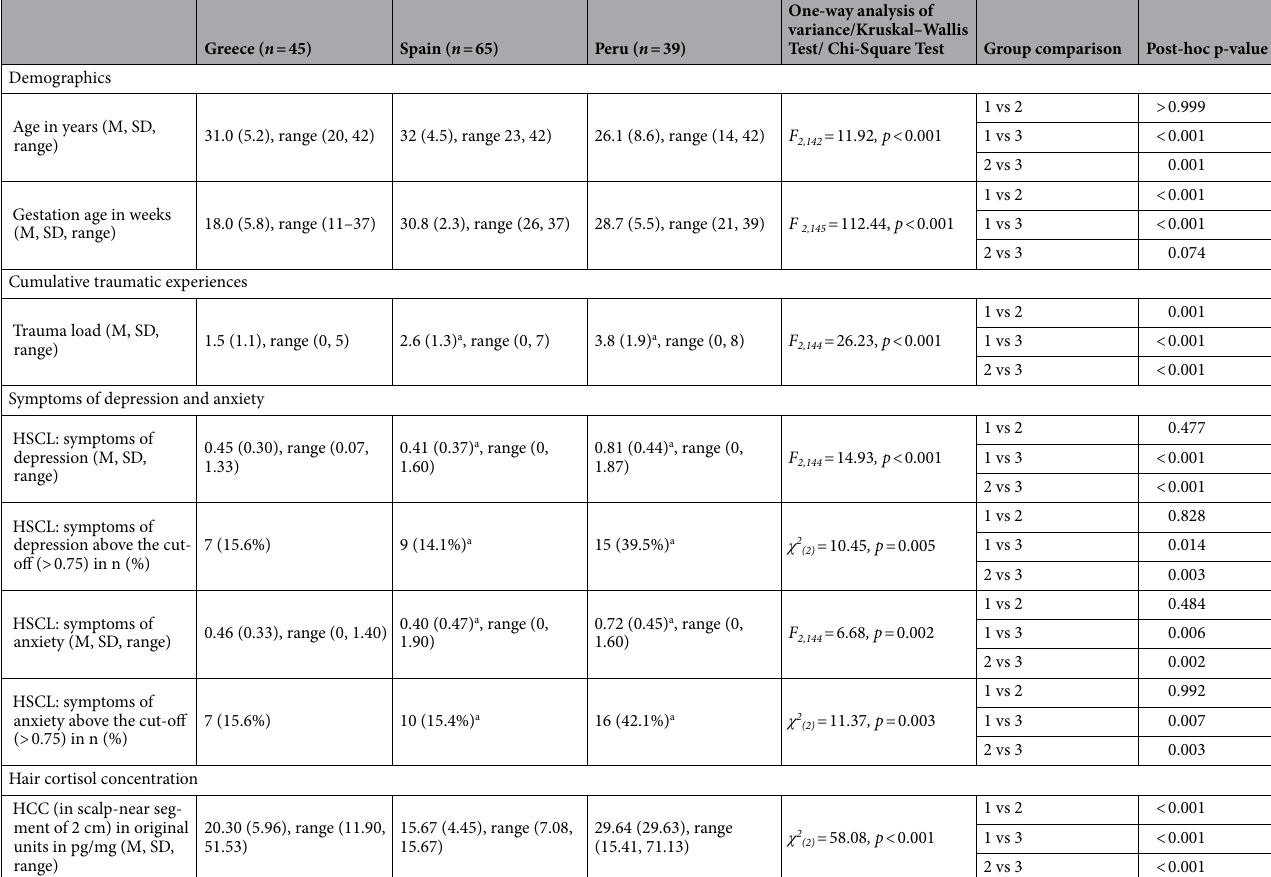
gesting substantial sensitivity to variations in gestational biology 13 . Cortisol plays a crucial role for healthy fetal